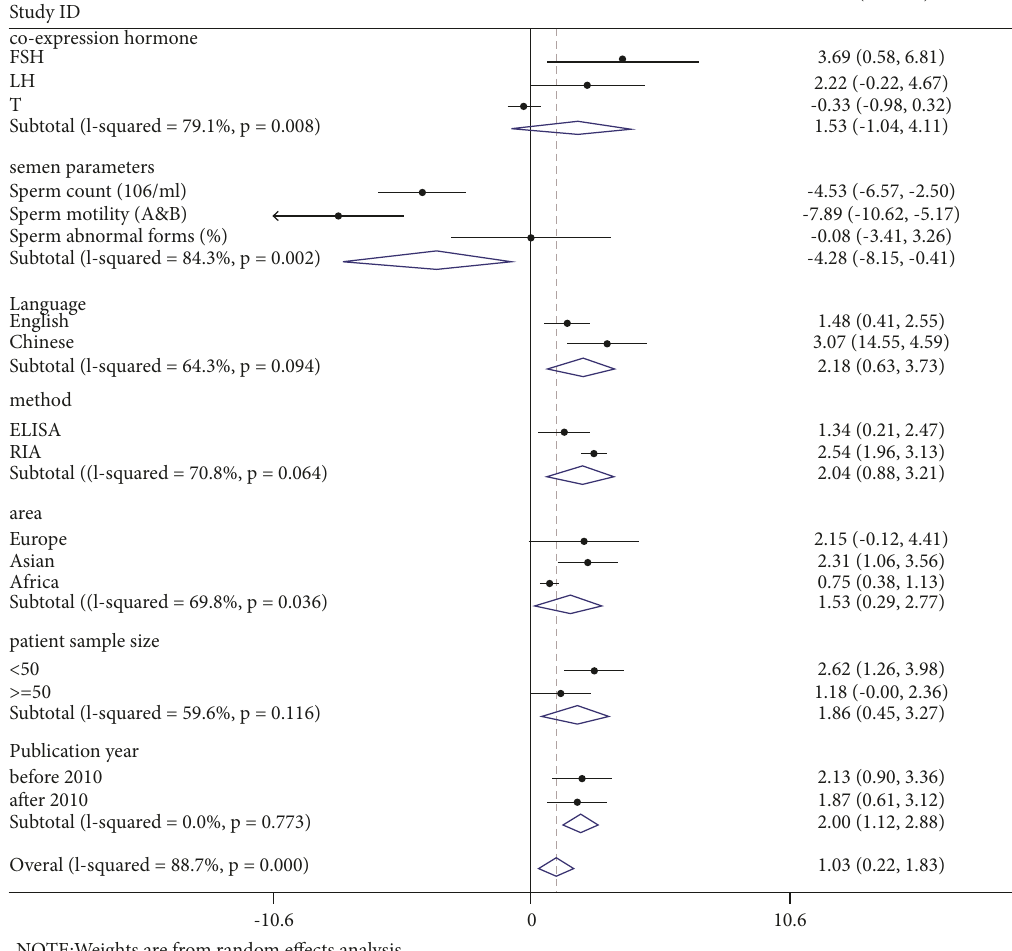
Figure 4: The estimates of SMD are based on 12 eligible studies providing serum leptin concentration with their 95% CIs. Note: FSH: follicle-stimulating hormone; LH: luteinizing hormone; T: testosterone; ELISA: enzyme-linked immunosorbent assay; RIA: